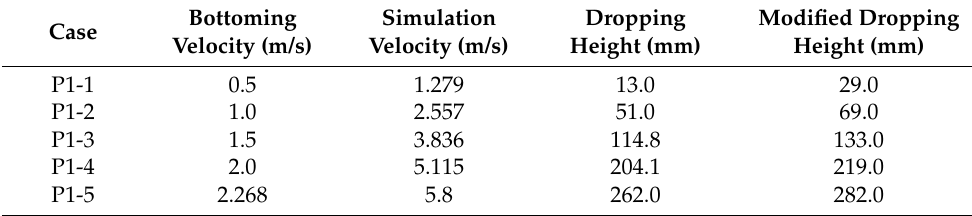
Table 13. T he physical parameters in model tests. Table 13. The physical parameters in model tests.